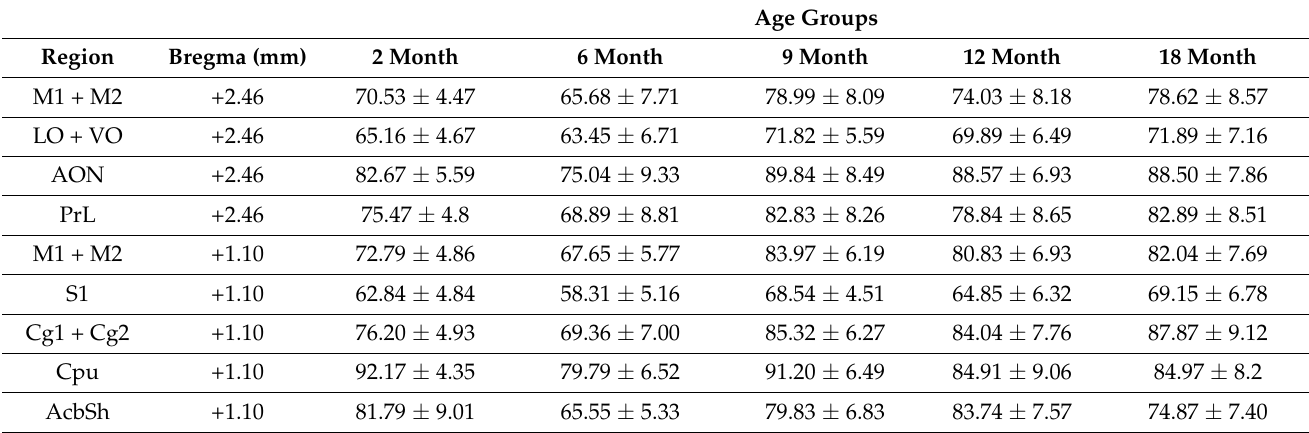
Table 1. Influence of age on CB1 specific binding in various brain